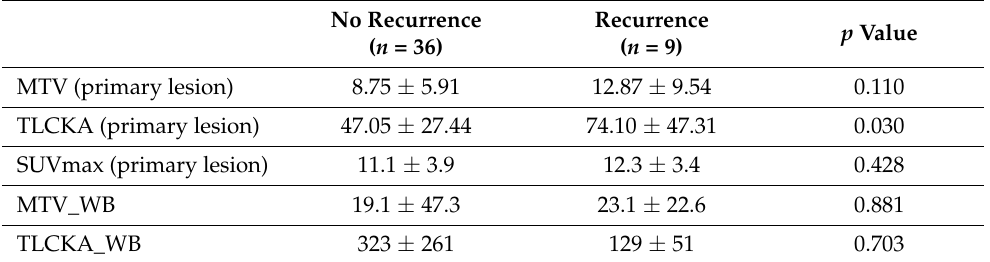
Table 4. Analysis of semiquantitative parameters extracted from [ 18 F]F-choline